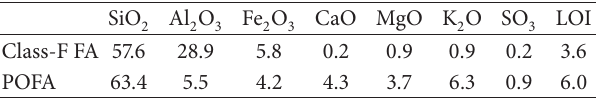
Table 1: Chemical composition (%) of class-F FA and POFA.